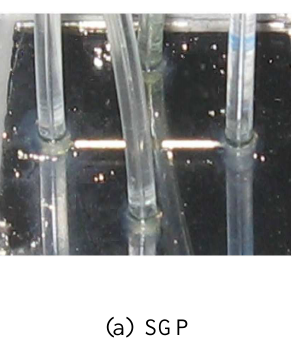
Figure 6: Microfluidic chips after packaging (a) SGP (b)